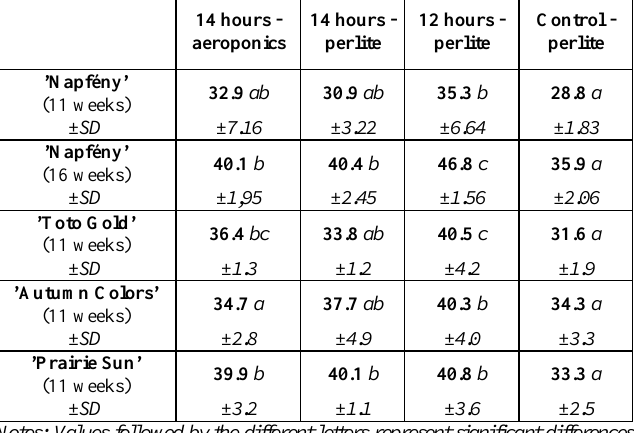
Table 4. Relative chlorophyll content (SPAD value) of Rudbeckia hirta L. plantlets depending on photoperiodic lighting treatments and media (University of Debrecen, Biological Research and Plant Experiment Greenhouse - Biodrome, Debrecen, Hungary, 2021).